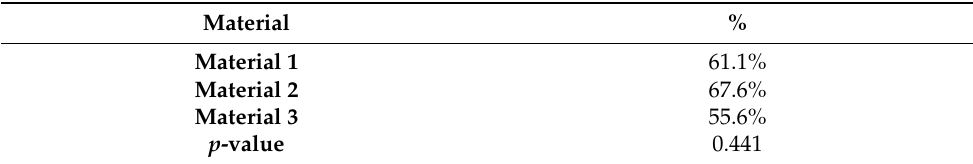
Table 2. Identification accuracy for each material, with the results of a Chi-Square test for detecting statistically significant differences among materials.